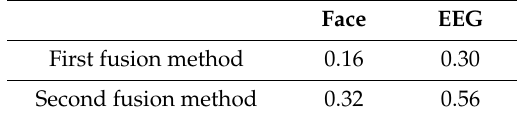
Table 5. The results of statistical tests in MAHHNOB-HCI dataset in arousal space.